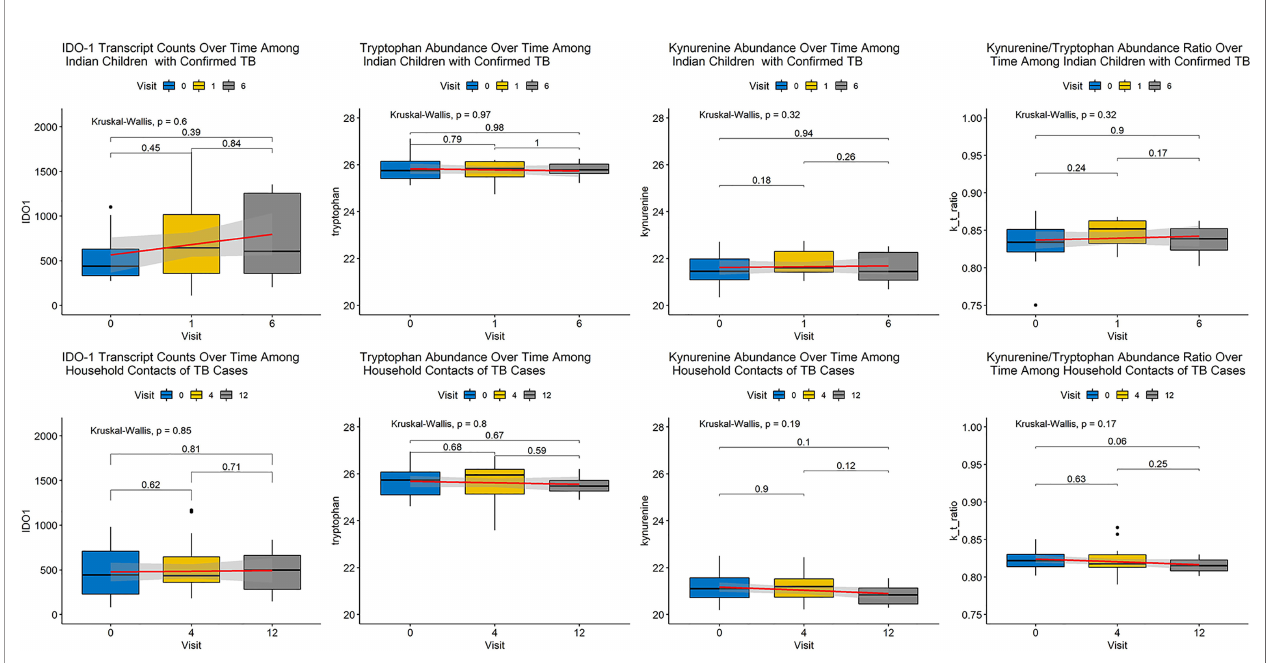
FIGURE 1 | Changes in Metabolite Abundance and Transcript Expression Over Time Among Cases and Controls. Abundance of each biomarker of interest is expressed as a boxplot with a smoothed regression line in red indicating change over time at each visit, indicated by month of visit. Shading around each red line indicates 95% con fi dence around the trend. The top row of panels contains plots for cases and the bottom row of panels indicates plots for controls. Each column represents a distinct biomarker with IDO-1 transcript expression in the left column, followed by tryptophan abundance, kynurenine abundance, and the kynurenine/ tryptophan (K/T) ratio moving from left to right. None of these biomarkers demonstrated a signi fi cant change over duration of follow-up among cases or